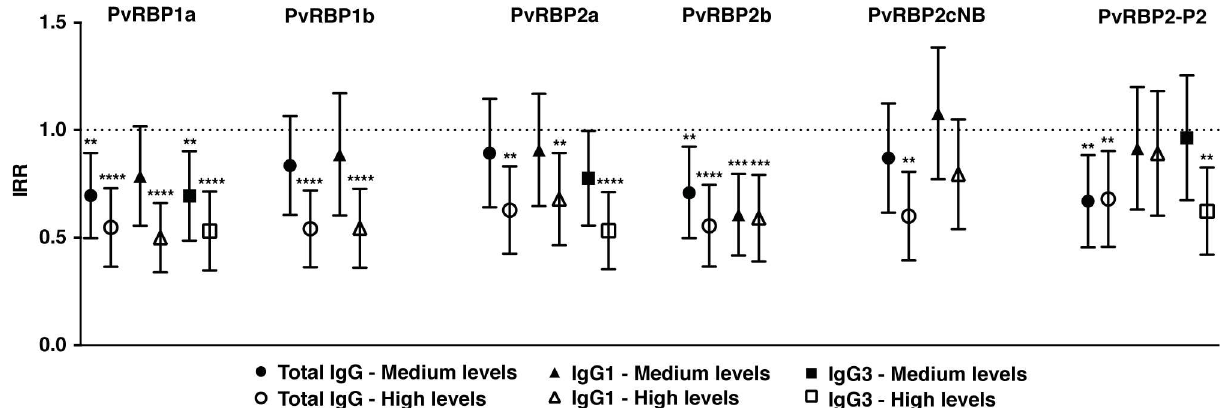
Fig 4. Associationbetween totaland IgG subclasses to 6 PvRBPs and protection againstclinicalmalaria(density > 500/ μ L)in 224 young Papua New Guinean children. Data are plotted as exposure (molFOB), age, season and village of residency adjustedincidence rate ratios and 95% confidenceintervals.Incidencerate ratios, 95% confidenceintervalsand P-values fromGEE models. P < 0.05 were deemedsignificant. **** P < 0.001; *** P = 0.001; ** P > 0.001 to 0.01; * P > 0.01 to